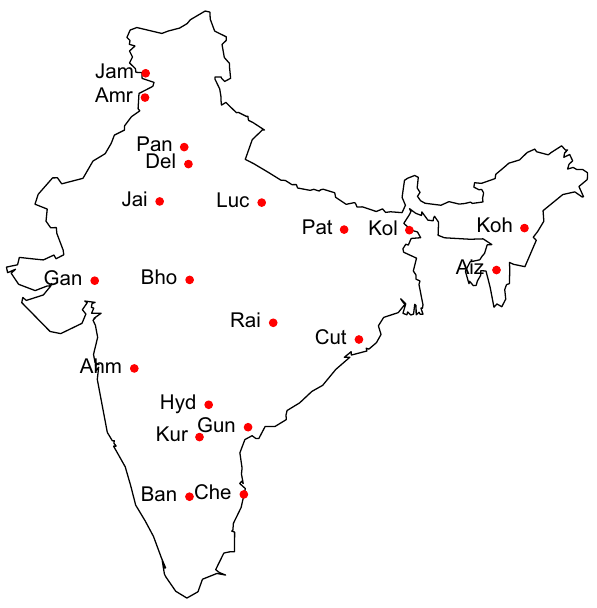
Fig. 1 Map showing location of various stations throughout India for which rainfall statistics and best-fit distributions were obtained. Each red point represents a station and next to it we show its first three let- ters. The full names of the cities can be found in Table 2. This plot has been made with the ggplot (Kahle and Wickham 2013) data visualization package in the R programming language, where “gg” in ggplot is an abbreviation for “Grammar of